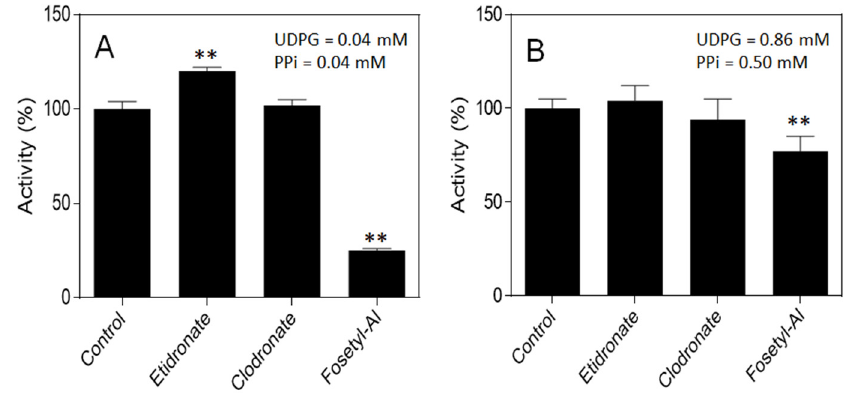
Figure 4. Effects of etidronate, clodronate and fosetyl-Al on activity of barley UGPase, assayed for the pyrophosphorolysis direction, at low ( A ) and saturating ( B ) concentrations of both UDPG and PP i . The phosphonates were at 1 mM each. Statistical significance in relation to control: ** ( p < 0.01).